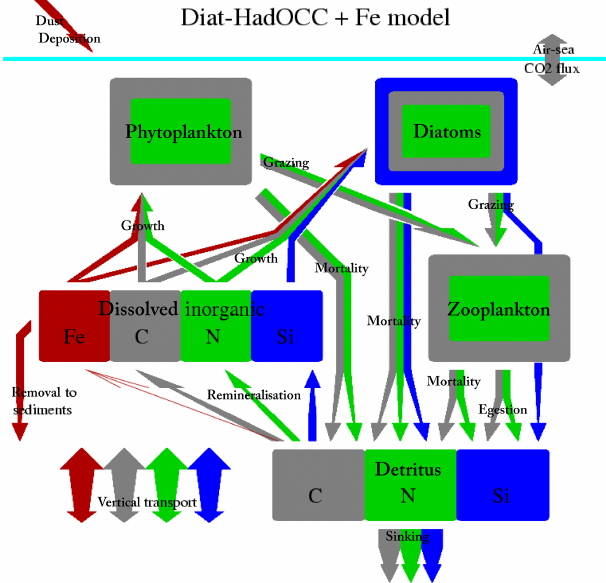
Figure 1. Diagram of the Diat-HadOCC model components and flows of nitrogen, carbon, silicon and